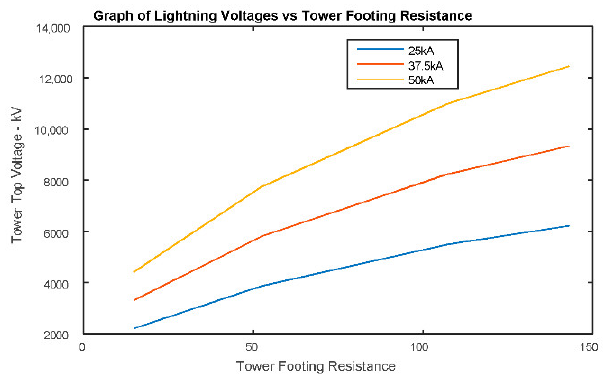
Figure 15. Tower Top Voltage variation vs. Tower Footing Resistance.